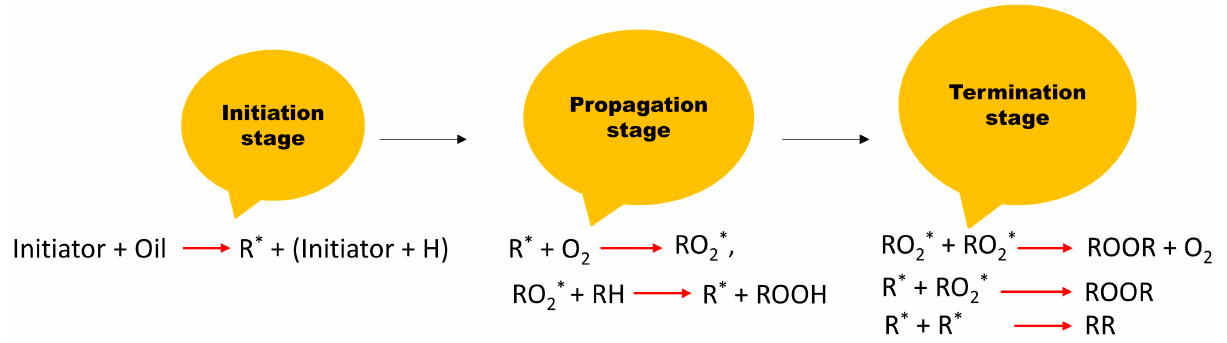
Figure 6. Stages of oil oxidation in vegetable oil.